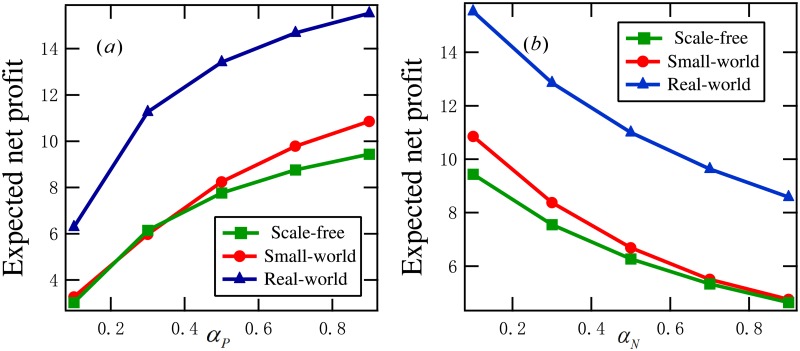
Experimental results in Example 5: (a) the optimal expected net profits for αN = 0.1 and αP ∈ {0.1, 0.3, ⋯, 0.9}, (b) the optimal expected net profits for αP = 0.9 and αN ∈ {0.1, 0.3, ⋯, 0.9}.